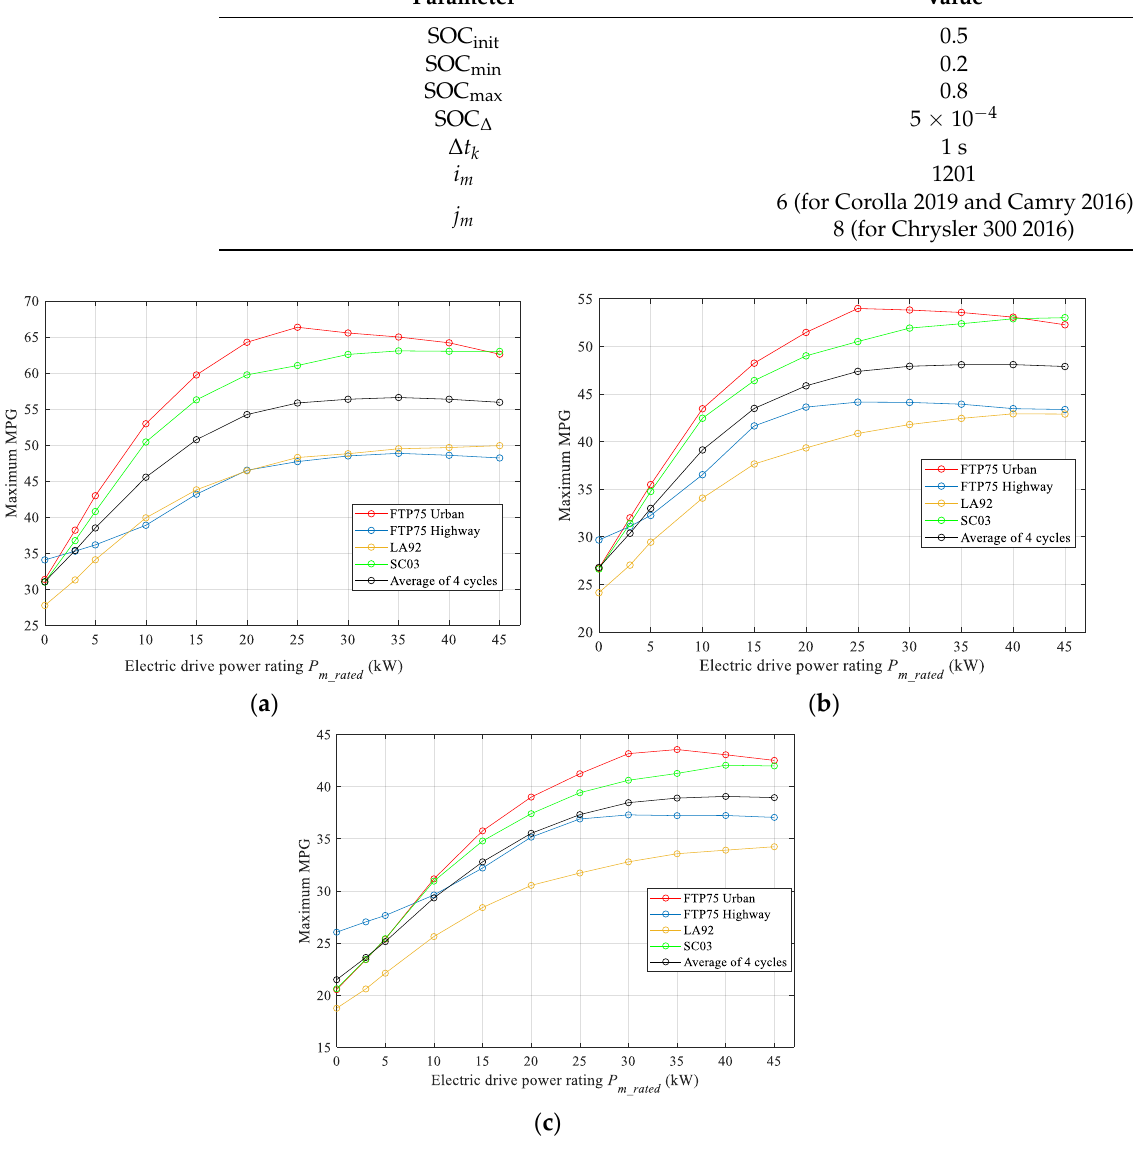
Figure 2. Maximum MPG versus electric drive power rating in typical driving cycles for hybridization of three typical vehicles: ( a ) Toyota Corolla 2019; ( b ) Toyota Camry 2016; ( c ) Chrysler 300 2016.